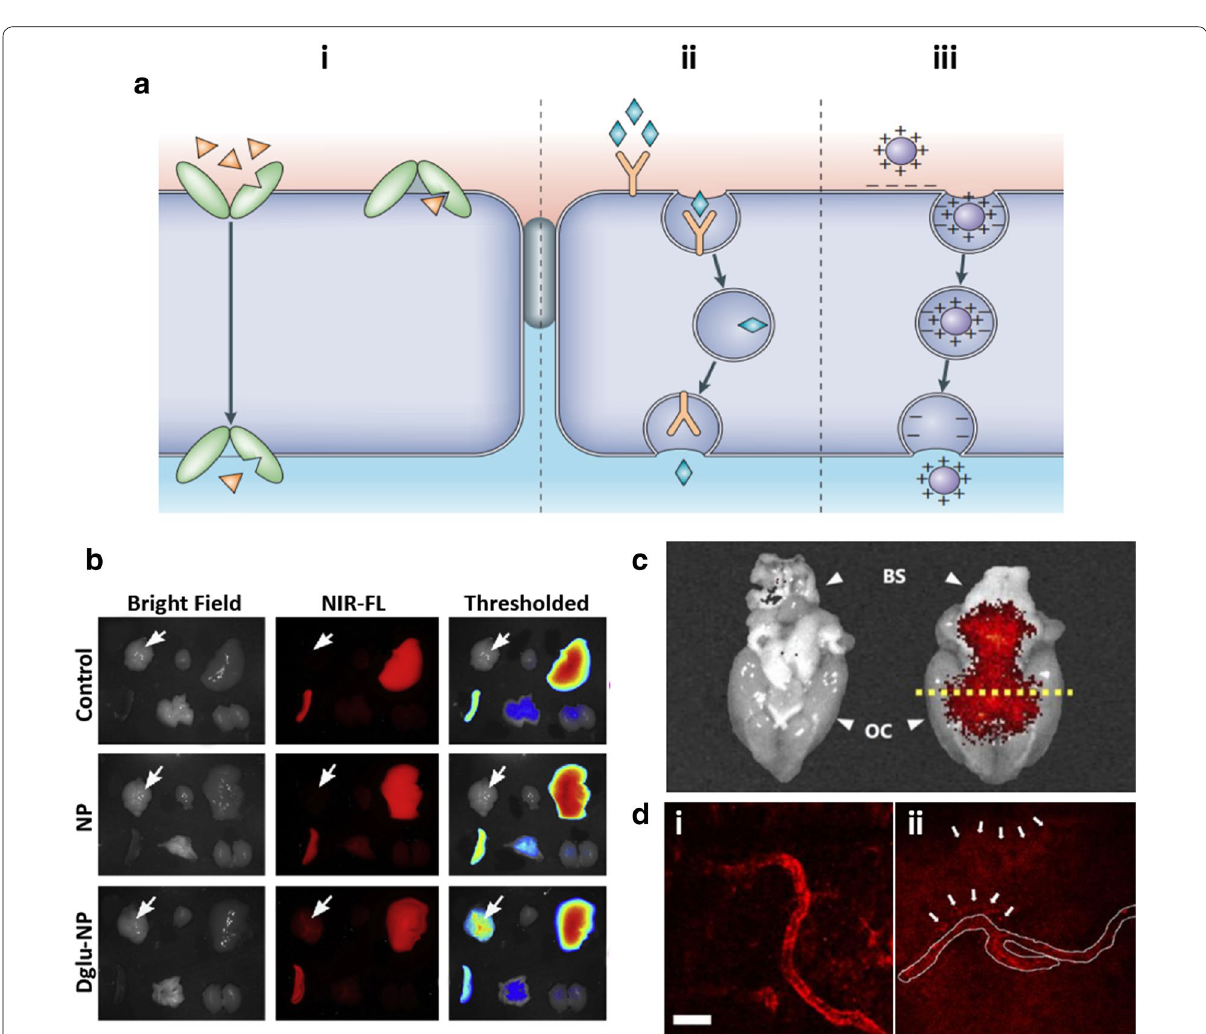
Fig. 2 Strategies for improving nanomedicine delivery passing through BBB. a Schematic representation of three major mechanisms to enhance BBB penetration: i transporter-mediated transcytosis, ii receptor-mediated transcytosis (RMT), and iii absorption. Reproduced with permission